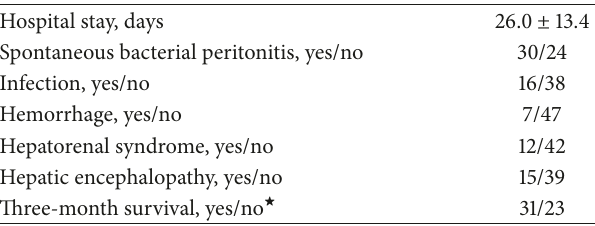
Table 3: Disease state during hospitalization and short-term prog-